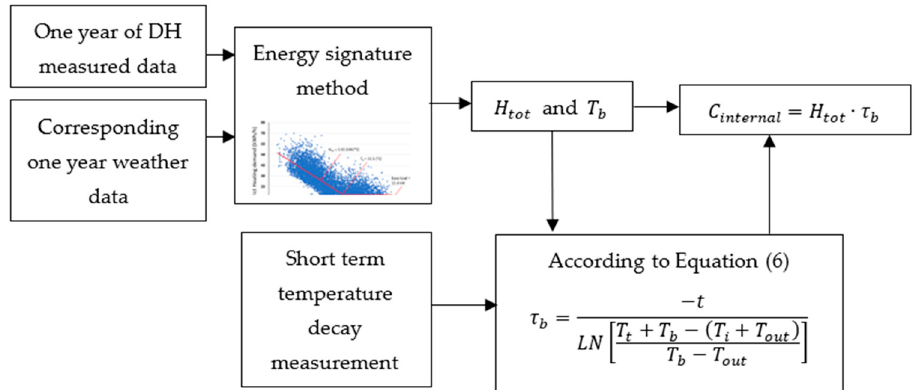
Figure 2. The schematic chart of the calculation procedure for the proposed heat load capacity model.